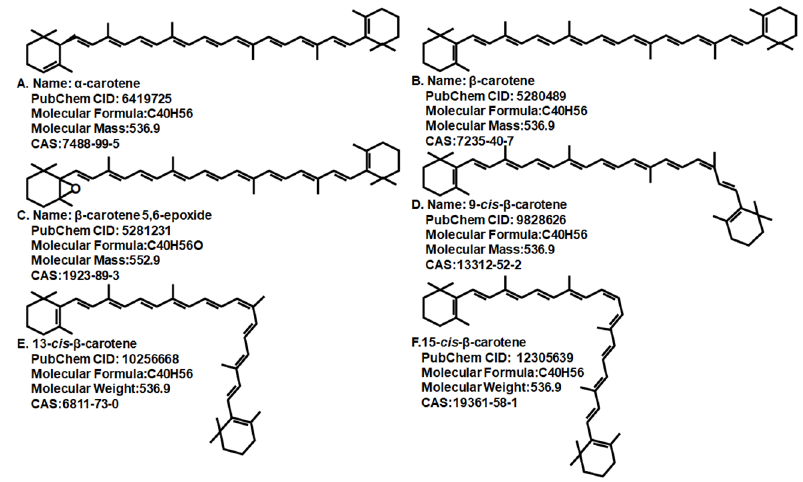
Figure 1. Structures and some physicochemical properties of α -carotene ( A ), β -carotene ( B ), β -caro- tene 5,6-epoxide ( C ), 9- cis - β -carotene ( D ), 9- cis - β -carotene ( E ), and 9- cis - β -carotene ( F